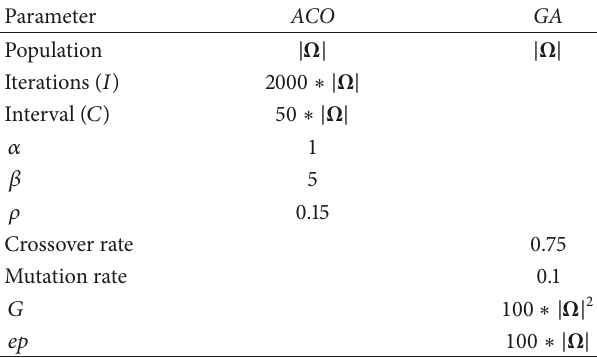
Table 2: The parameter setting for the AGNA